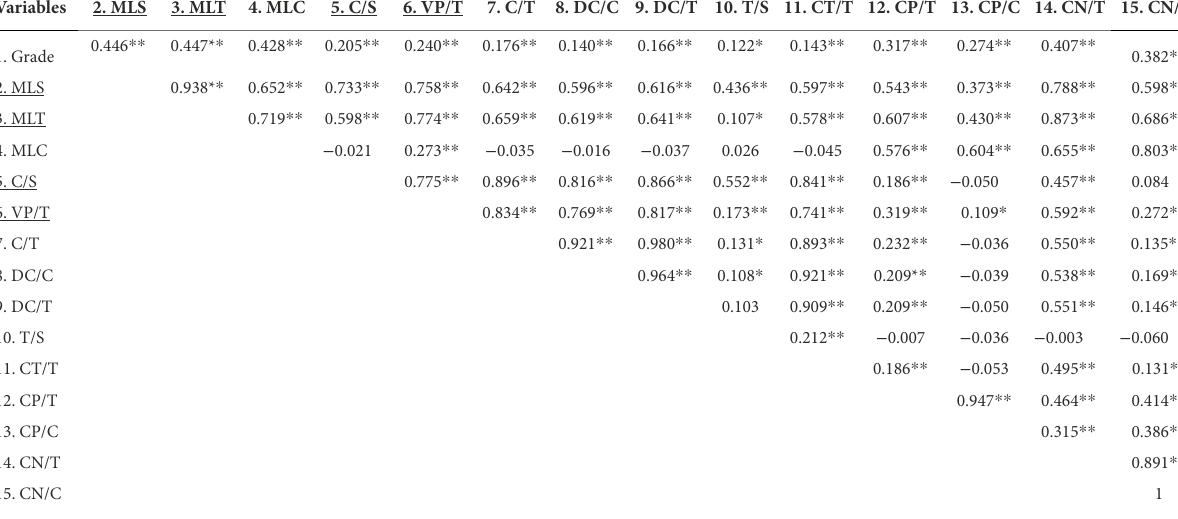
TABLE 4 Pearson’s correlation between grades and syntactic complexity indices.